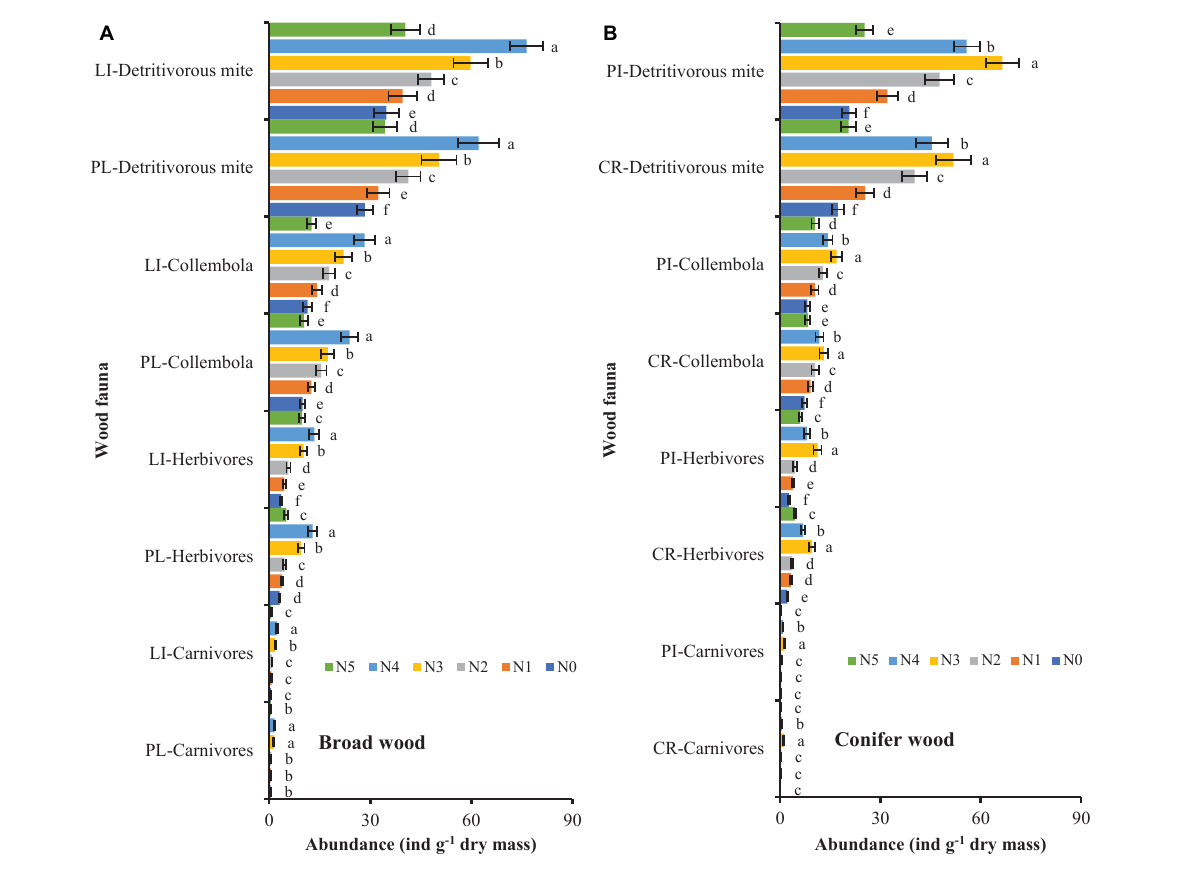
FIGURE5 Change in the abundance of soil fauna functional groups present in (A) broadleaf (PL and LI) and (B) coniferous (CR and PI) wood samples under different N fertilization treatments over a 24-month experimental period. Error bars indicate the standard error ( n = 6). Bars with different letters differ significantly among same wood fauna community and same tree species under different N fertilization treatments (N5, N4, N3, N2, N1 or N0) at p < 0.05. N5, IN:ON = 0:10; N4, IN:ON = 3:7; N3, IN:ON = 5:5; N2, IN:ON = 7:3; N1, IN:ON = 10:0 and N0, control. Cryptomeria japonica ( CR ), Platycarya strobilacea ( PL ), Pinus taiwanensis ( PI ) and Lithocarpus glaber ( LI